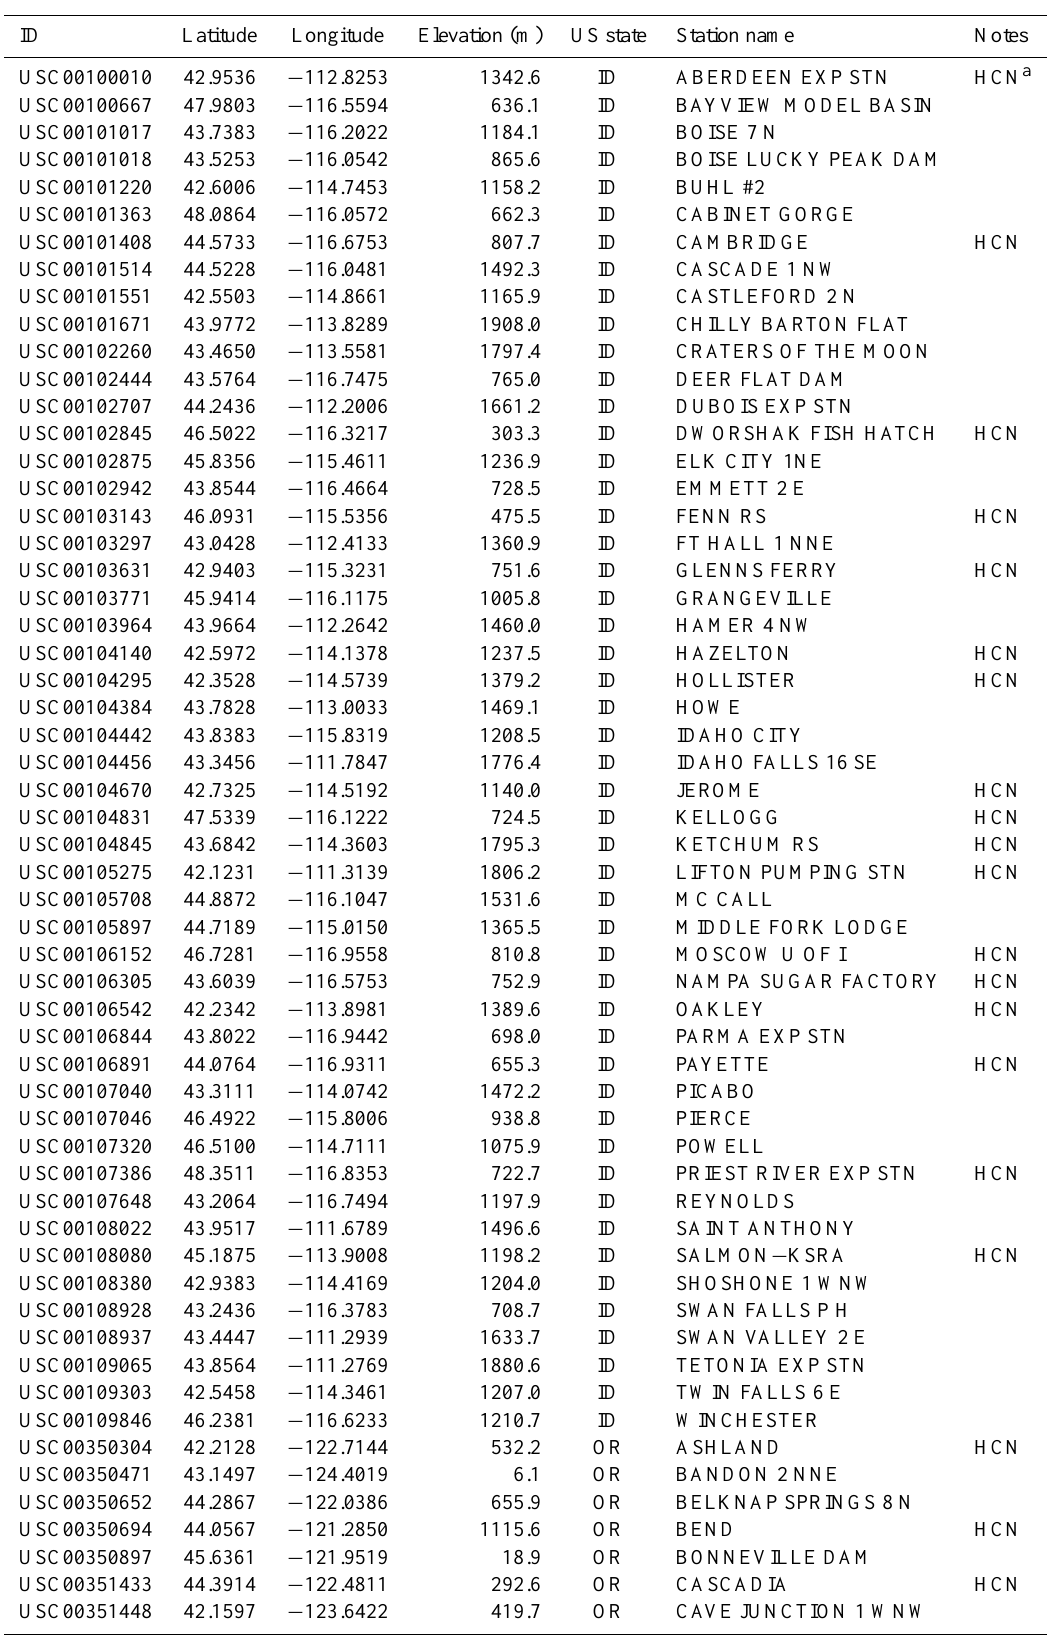
Table A1. GHCN station